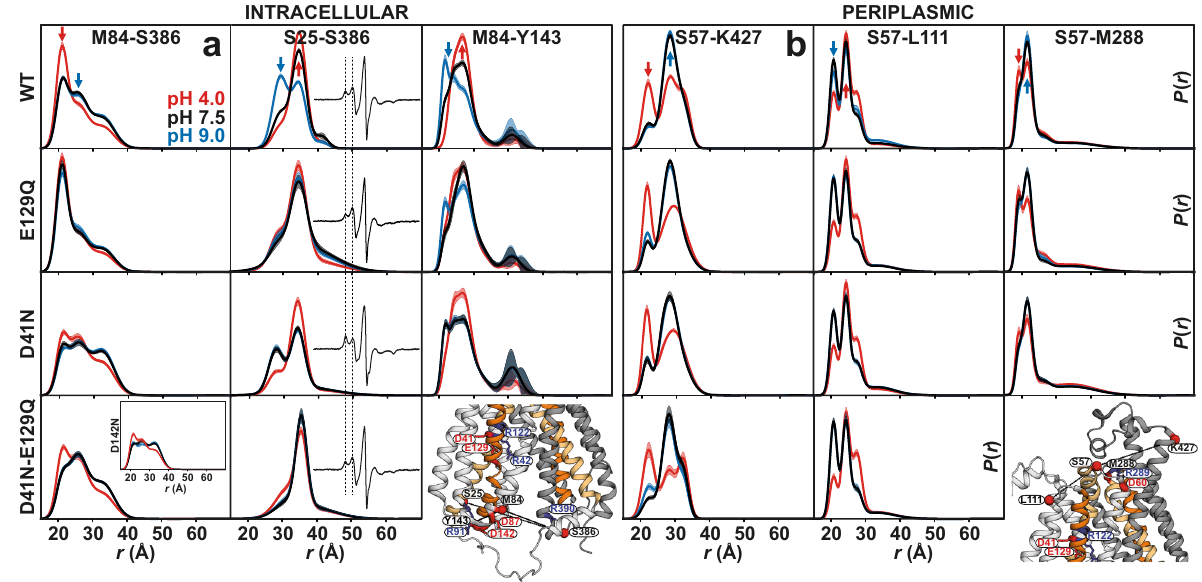
Fig. 7 | Weak coupling of proton-dependent conformational changes on the intracellular and periplasmic sides of Hn Spns. Effect of protonation-mimetic mutation of acidic residues on conformational states in equilibrium on the a intracellularand b periplasmicside (SupplementaryFigs. 7 – 10).The single (E129Q, D41N, and D142N) or double (D41N/E129Q) mutations were combined with the double-cysteine mutations. DEER experiments in the presence of these mutations